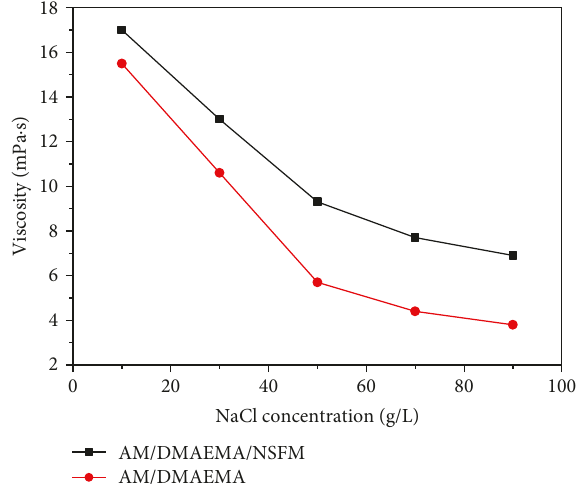
Figure 5: Salt tolerances of AM/DMAEMA and AM/DMAEMA/ NSFM solutions (0.2 wt%) at 30 ° C. The viscosities of copolymer solutions (0.2 wt%) were measured with a Brook fi eld DV-II viscometer using a no. 63 rotor (rotation speed: 30